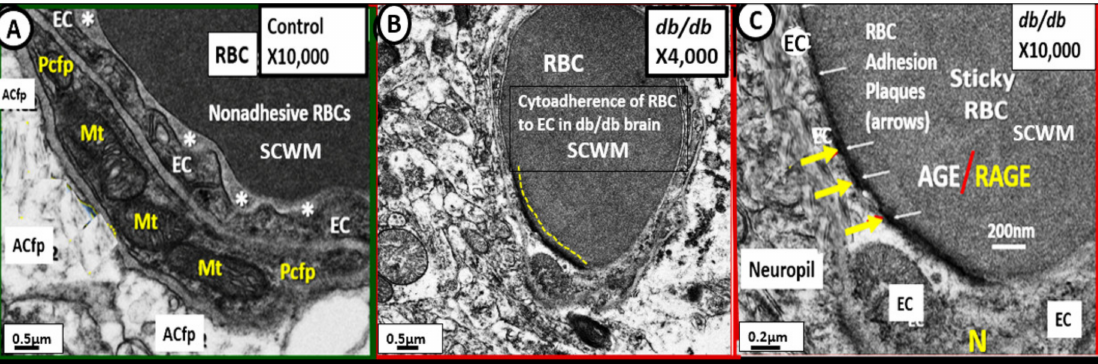
Figure 14. Cytoadherence of red blood cell(s) (RBCs) to the neurovascular unit (NVU) brain endothe- lial cells (BECs) in subcortical white matter (SCWM) regions in the obese, insulin resistant diabetic db/db mice. Panel A demonstrates the relationship between the NVUs RBC and the BEC. Note that while the RBC comes in close proximity to the BEC, it does not adhere to it. Asterisks denote a definite space between the RBC and BEC. Panel B depicts a low magnification image of the NVU and note that the RBC in this capillary lumen appears to be adherent to the BEC (yellow dashed line). Panel C depicts a definite highly electron-dense adhesion plaque between the capillary RBC and the endothelium (arrows) of the neurovascular unit. There is known to be an increase in RBC HbA1c and advanced glycation end-products (AGE) that may locate to the surface of RBCs and this could bind to the increase in the receptors of the advanced glycation end-products RAGE known to be increased in the BECs of diabetes. This AGE/RAGE interaction helps to better understand this attraction between the RBC and BEC and additionally helps to understand the formation of the electron-dense adhesion plaques observed. Additionally, the BEC glycocalyx is known to be damaged and attenuated in the diabetic db/db pulmonary capillaries and the diabetic BTBR ob/ob preclinical mouse models that would also support RBC cytoadhesion (Section 5.1). Incidentally, there were similar RBC cytoadhesions in left ventricle capillaries of the myocardium in female db/db mice at 20-weeks of age in this same model. Images modified with permission by CC 4.0 [32,36]. Magnification × 10,000; scale bar = 0.5 µ m ( panel A ), × 4000; scale bar= 0.5 µ m ( panel B ), × 10,000; scale bar = 0.2 µ m ( panel C ). ACfp = astrocyte foot processes; Mt = mitochondria; Pcfp = pericyte foot